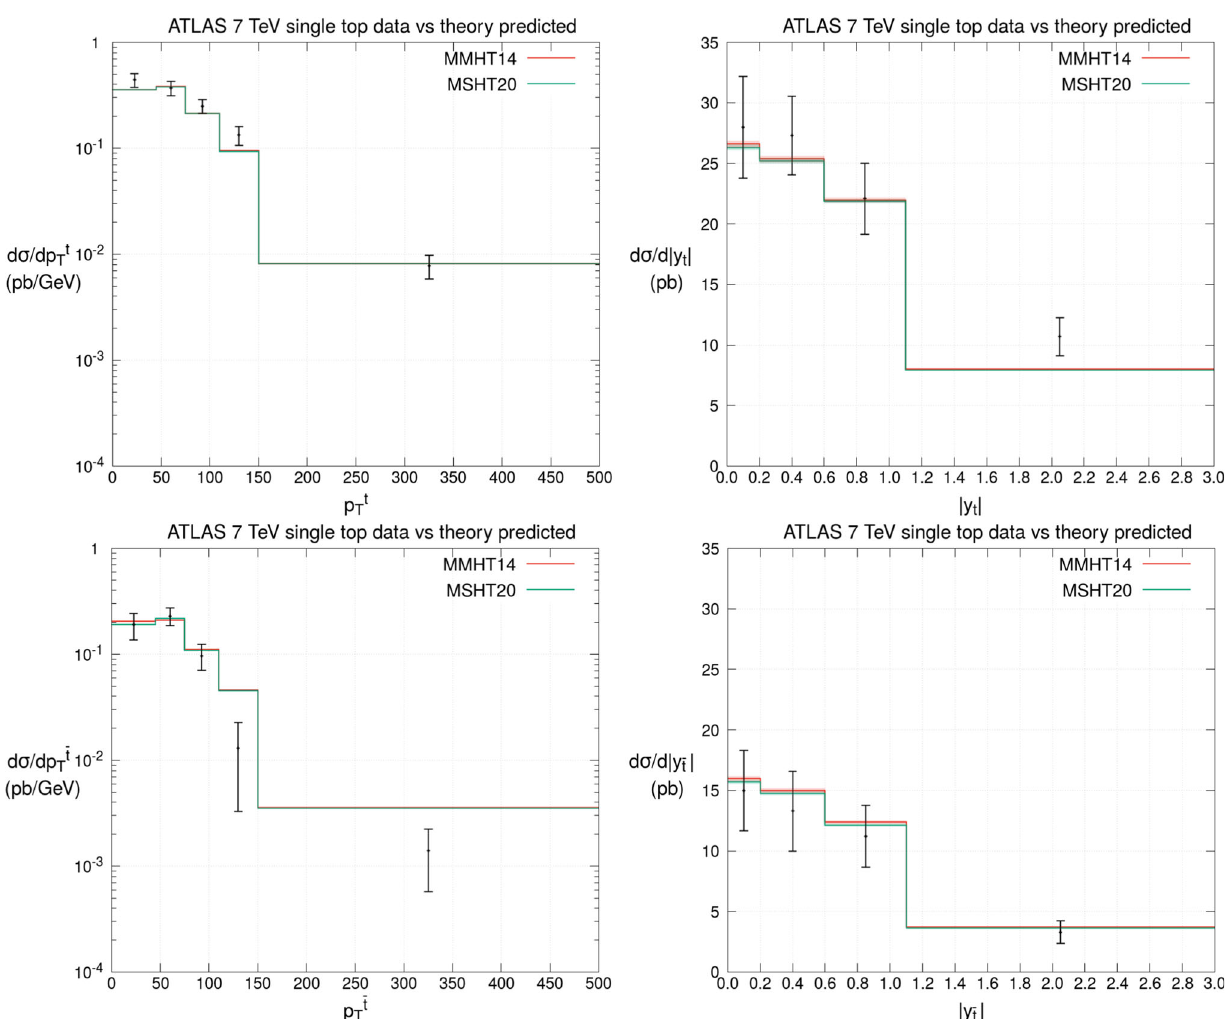
Fig. 87 MMHT14 and MSHT20 NNLO predictions for t -channel sin- gle top (upper plots) and anti-top (bottom plots) production, differential in the top/antitop p ⊥ (left-hand plots) and rapidity (right-hand plots),